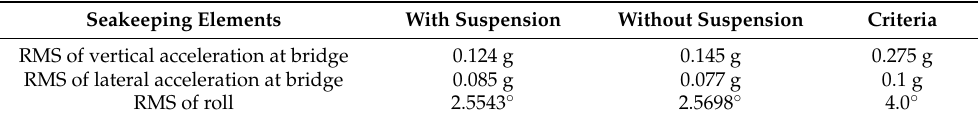
Table 7. Seakeeping criteria values with hard